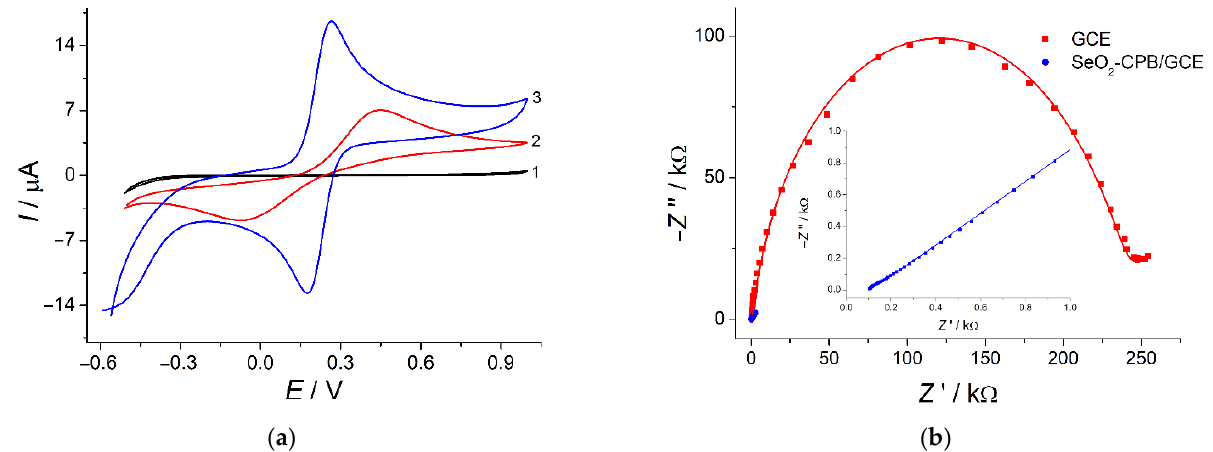
Figure 5. Electrodes surface morphology obtained by scanning electron microscopy: ( a ) bare GCE; ( b ) SeO 2 –CPB/GCE.